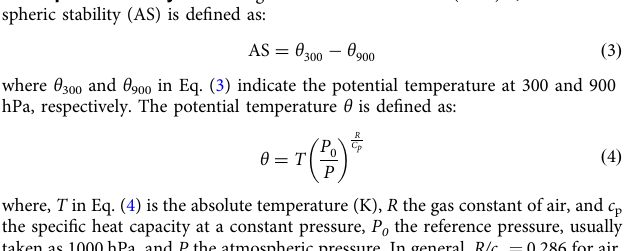
where c p in Eq. (2) is the speci fi c heat capacity at constant pressure, usually taken as 4178Jkg − 1 °C − 1 ; ρ the density of sea water, taken as 1026kgm − 3 in the upper ocean; D 26 the depth of the 26°C isotherm, and T(z) the in-situ temperature from the ocean analysis data. The annual TCHP series is obtained from the average of six